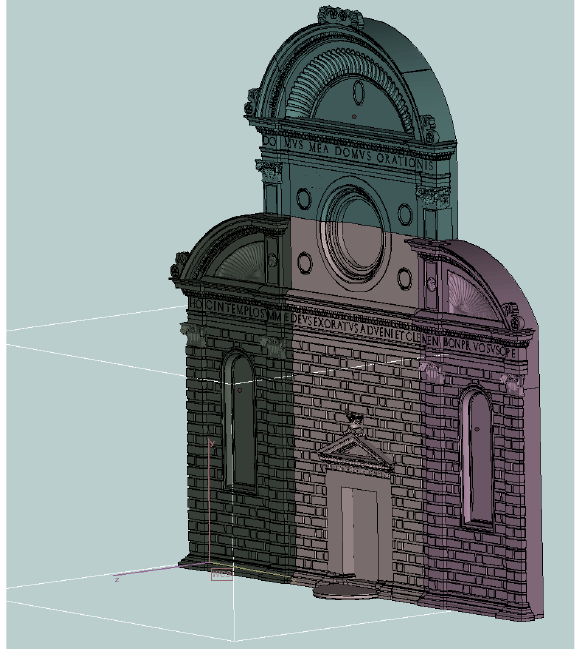
Figure 7. The STL model divided into 4